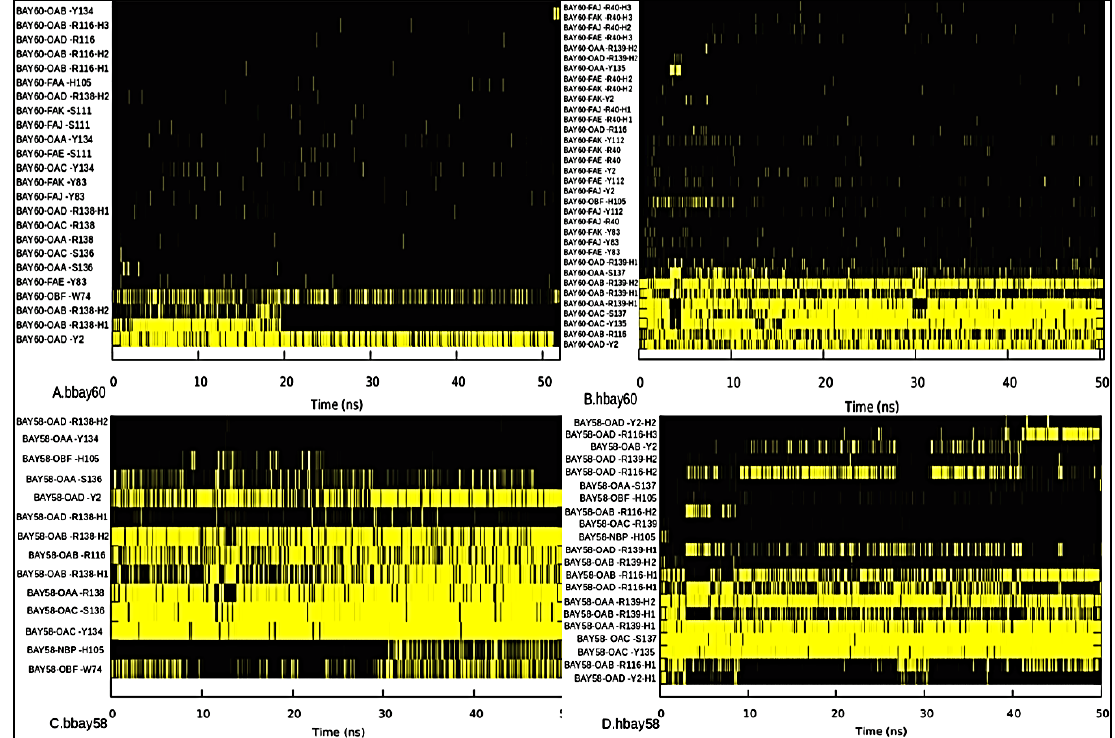
Figure 7. Hydrogen bond occupancy as observed in bbay60 ( A ), hbay60 ( B ), bbay58 ( C ) and hbay58 ( D ) complexes during 50 ns simulation period, outlaid at X-axis. Y-axis shows hydrogen bond forming atoms of the BAY compounds and binding residues of H-NOX, the atom abbreviations are same as illustrated in Figure 1. Hydrogen bonds were recorded throughout the 50 ns trajectory in all the four complexes. Yellow bars indicate the event of hydrogen bond formation as observed at that point of time at X-axis. Length of the yellow trace illustrates the occupancy or the time duration for which the respective hydrogen bond was observed.